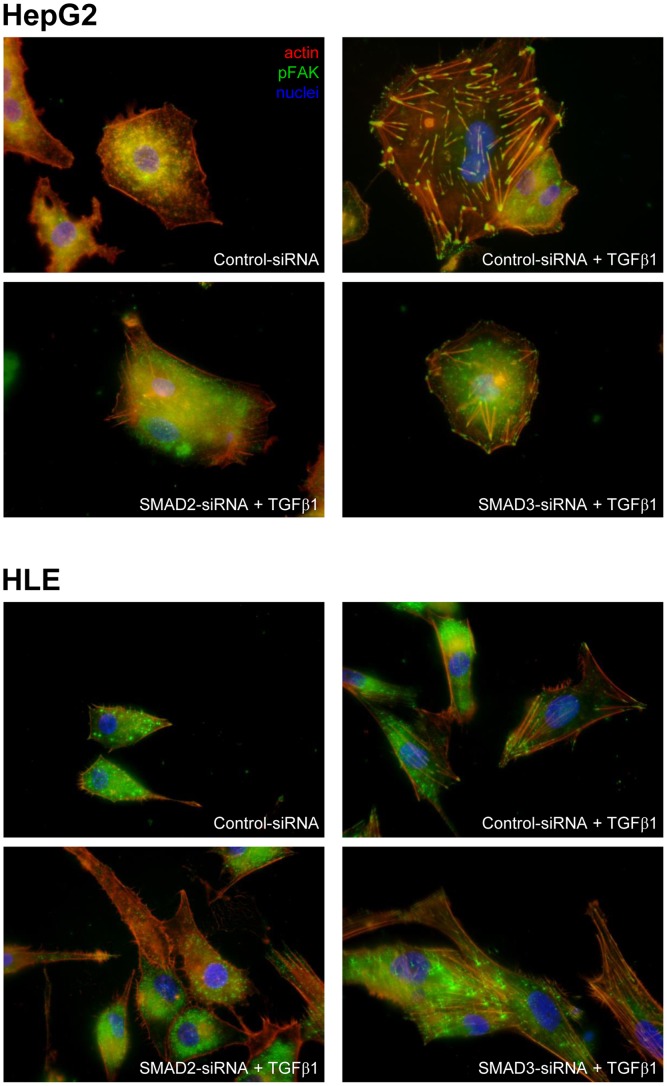
Immunofluorescence staining of F-actin and p-FAK in HepG2 and HLE siRNA for Smad-2 and Smad-3 after stimulation with TGF-β.HepG2 and HLE cells silenced for Smad-2 and Smad-3 were incubated with TGF-β under the same experimental conditions described for migration experiments. Cells were fixed with 4% paraformaldehyde, stained with TRITC-phalloidin and anti-pFAK antibody and examined under a NIKON eclipse E1000 fluorescence microscope. Mag = 600×.